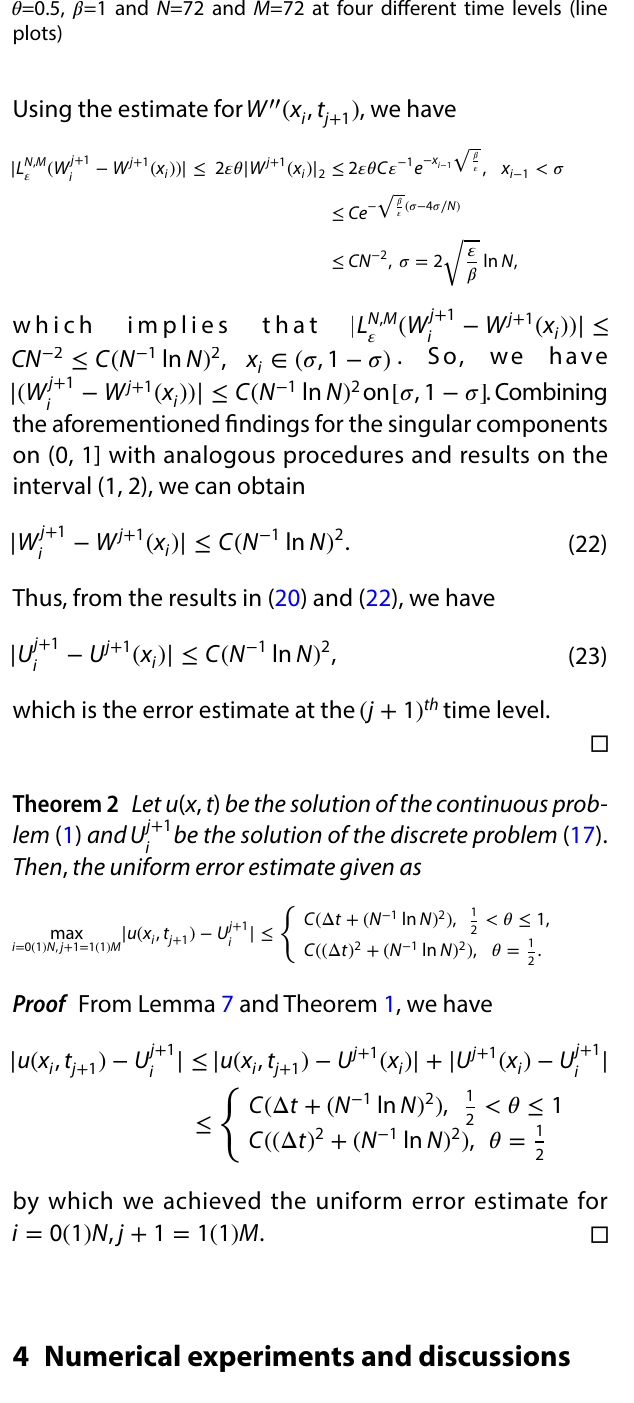
Fig. 1 Simulations for the numerical solution of Example 1, taking 𝜃 =0.5, 𝛽 =1 and N =72 and M =72 at four different time levels (line plots)